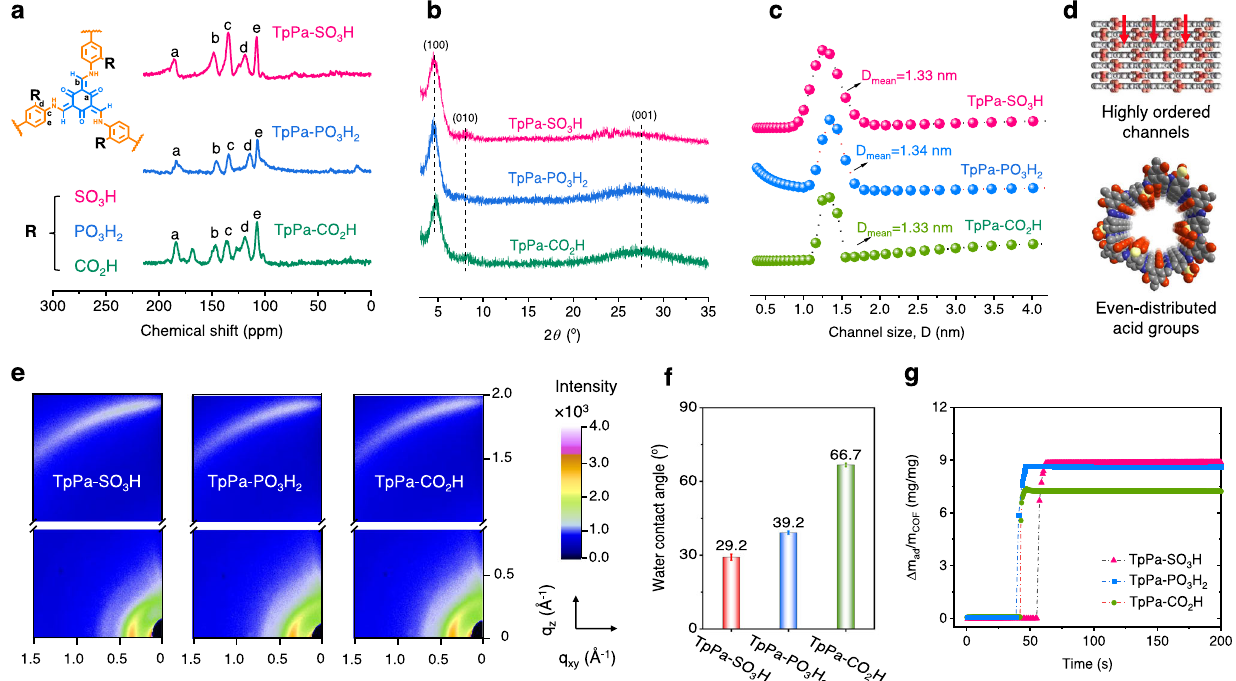
Fig. 3 | Characterizations of chemical, crystalline, and pore structures of COF membranes. a 13 C MAS NMR spectra. The peaks corresponding to C=O and C – N were detected at ~185 ppm and 150 ppm for COFs membranes, revealing the existenceofketo-structureswithinthemembranes. b XRDpattern.Twosignalscan be observed in 2 theta of 5° and 27 – 27.5° attributed to crystalline planes of (100) and (001), respectively, manifesting the high crystallinity of COF membranes. c Pore size distribution. The average channel size of membranes concentrated on